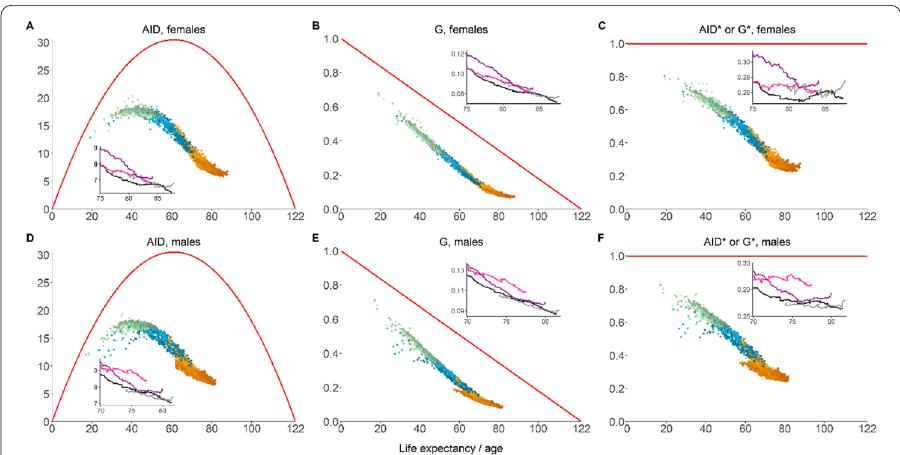
Fig. 4 Life expectancy and lifespan inequality for different inequality indicators, 1832–2020, HMD countries. A Absolute Gini for females; B relative Gini for females; C normalized Gini for females; D absolute Gini for males; E relative Gini for males; F normalized Gini for males. Red curve for maximal inequality given maximal lifespan 122, black line for Japan, dark magenta line for Canada, pink line for Taiwan, grey line for Hong = Kong. Normalized indices were calculated when maximal lifespan equals 122. (Source: Authors’ elaboration based on the HMD